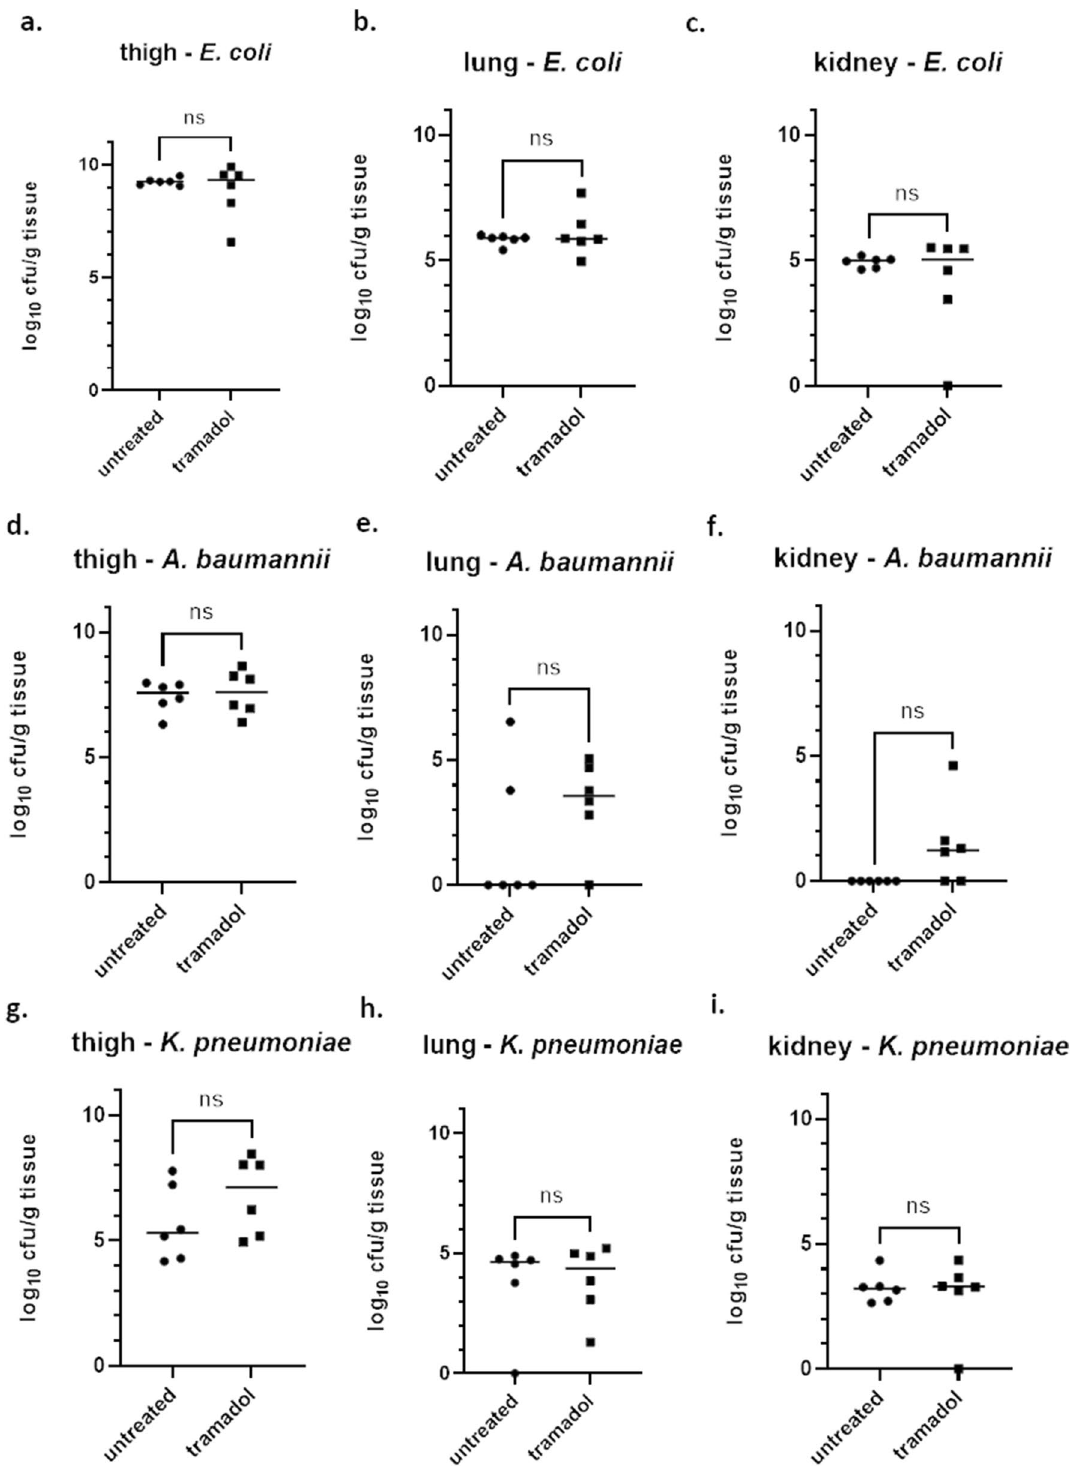
Figure 4. Bacterial burden in untreated and tramadol-treated groups in the neutropenic thigh infection model with three different species of the ESKAPE pathogens. Bacterial burden expressed as cfu/g tissue was assessed for groups that were treated with either 20 mg/kg tramadol subcutaneously or left untreated (n = 6 per group). All groups were either infected with E. coli ( a-c ) or with A. baumannii ( d-f ) or K. pneumoniae ( g-i ). Bacterial burden was assessed in thigh ( a,d,g ), lung ( b,e,h ) and kidney ( c,f,i ). Statistical testing was performed using a Kolmogorov–Smirnov test. Ns not